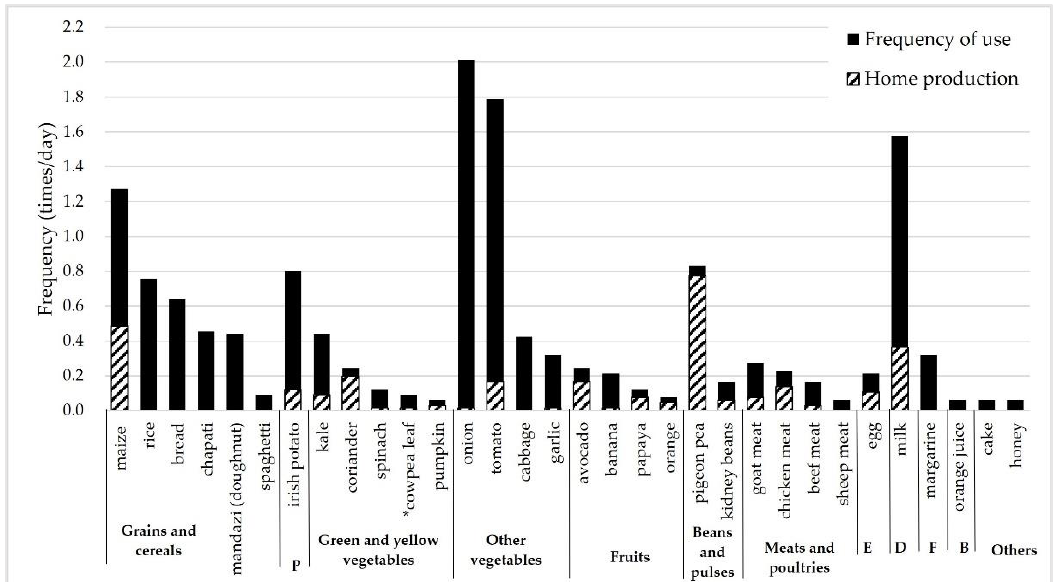
Figure 2. Frequency of consumption and home production of each food item in Kitui. (Bold font indicates food groups. P: Potatoes and starches, E: Eggs, D: Dairy products, F: Fats, B: Beverages. * African leafy vegetables, A total of 66 items were consumed, and 34 items were homegrown or produced in 11 households in Kitui. Food rarely consumed (less than 0.05 times per day), tea leaves, coffee, sugar, salt, royco (seasoning), and cooking oil were excluded.).